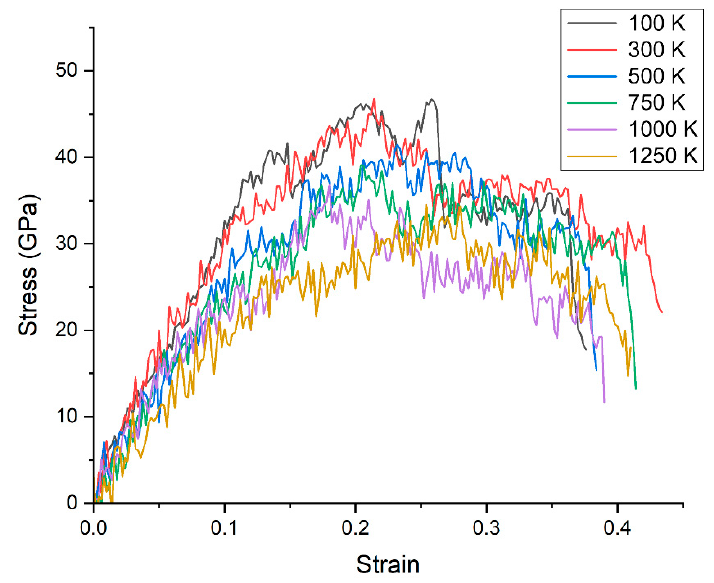
Figure 9. Stress-strain curves of PGO under uniaxial tension at different temperatures.